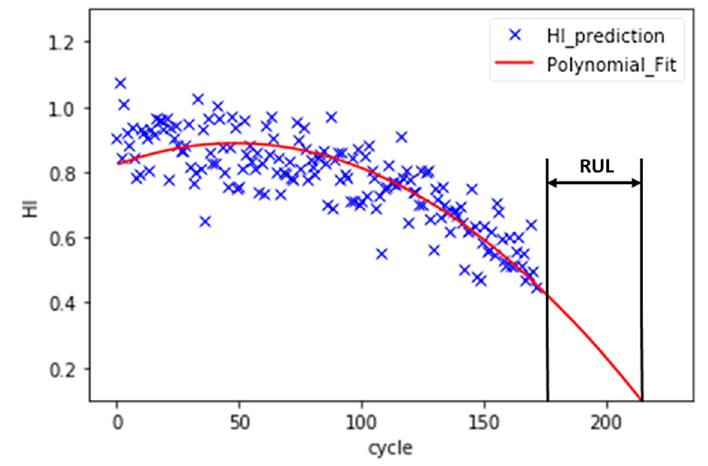
Figure 7. The HI prediction and RUL estimation for FD001_test turbo engine unit 84.